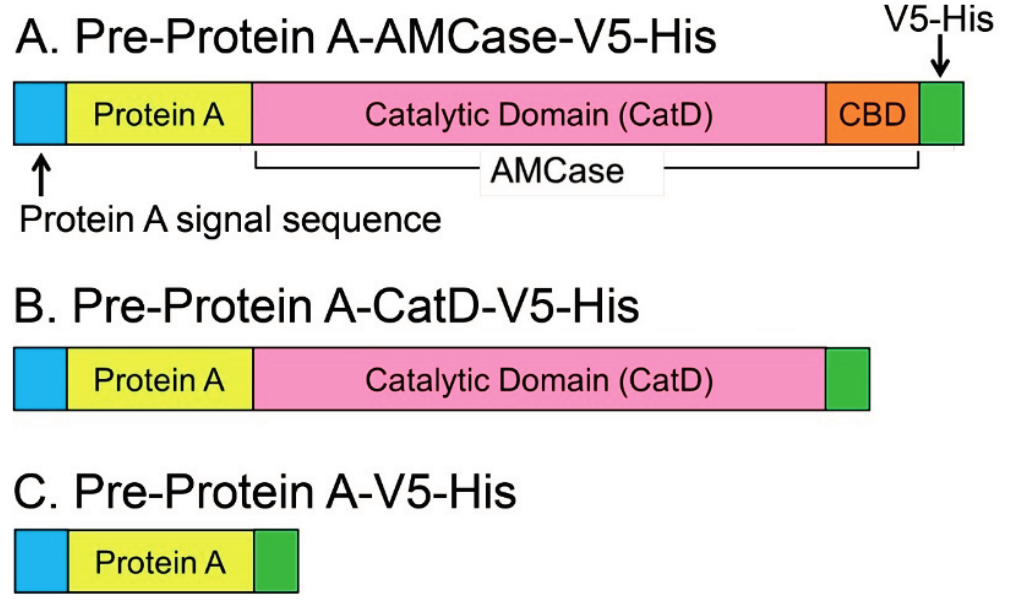
Figure 1. Schematic representations of the Escherichia coli -expressed fusion proteins. Mouse AMCase contains an N -terminal catalytic domain (CatD) and a C -terminal chitin-binding domain (CBD). ( A ) Pre-Protein A-AMCase-V5-His; ( B ) Pre-Protein A-CatD-V5-His; and ( C ) Pre-Protein A-V5-His. The newly synthesized recombinant proteins contain the Protein A signal sequence, which is processed during